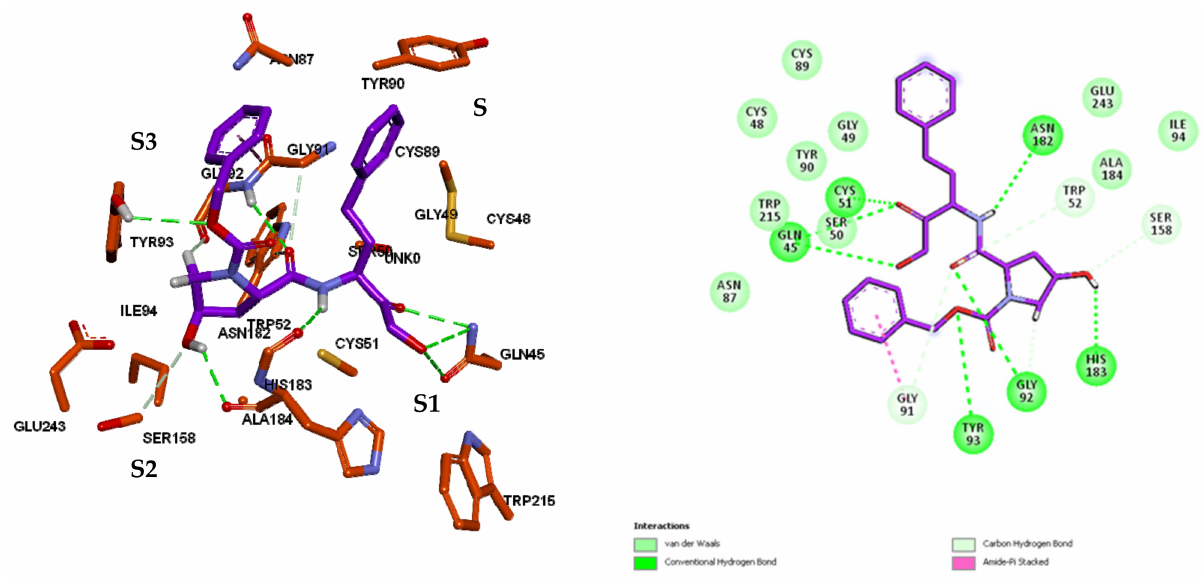
Figure 4. Proposed binding mode of peptidomimetics inhibitors at the active site of FP3. Main favourable non-bond interactions depicted in 3D ( left picture ) and 2D ( right picture ) for the most active PEP39 (purple carbons